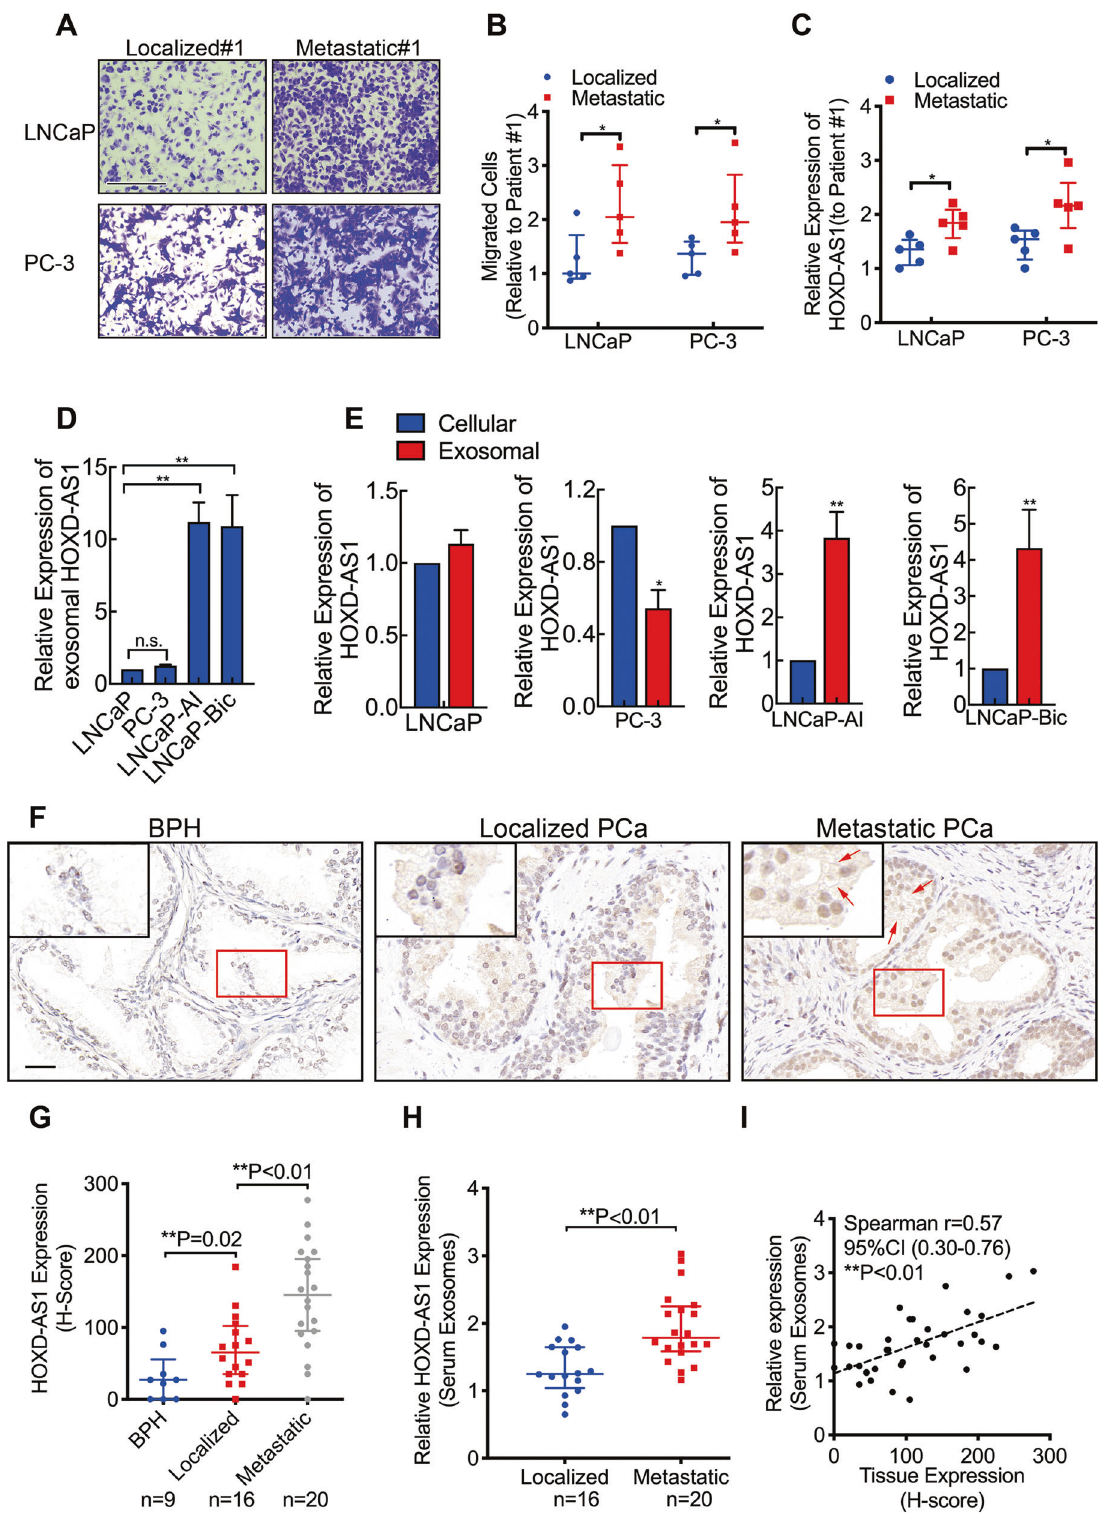
metastasis. Our fi ndings highlight the mechanism of exosomal HOXD-AS1 mediated transmitting of metastatic features in the PCa TME, and identi fi ed exosomal HOXD-AS1 as a potential marker of liquid biopsy for metastasis in